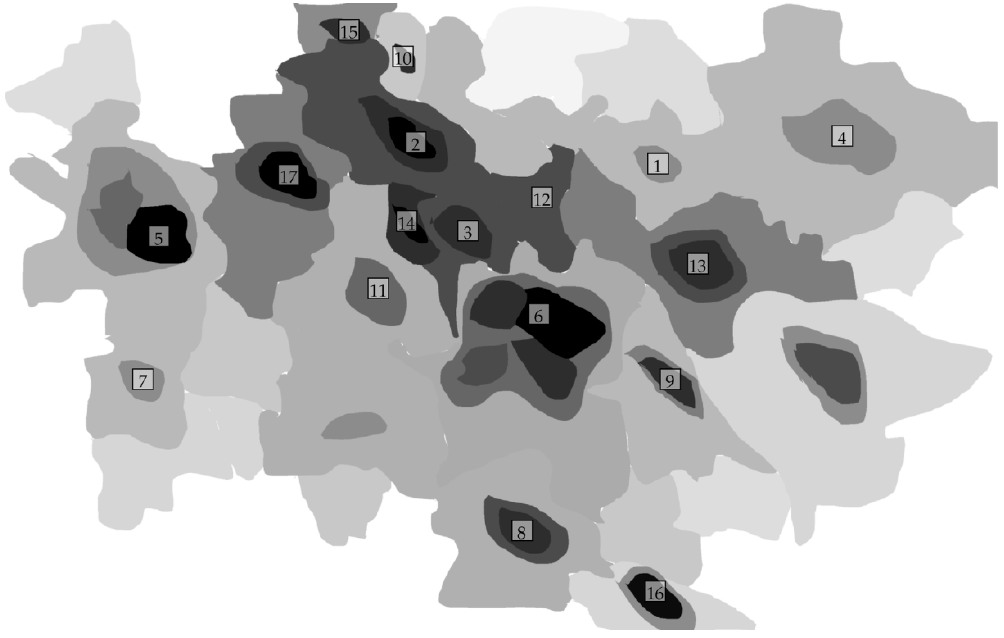
Figure 5. Map of population density (white—below 250 pers./km 2 , black—above 4000 pers./km 2 ).